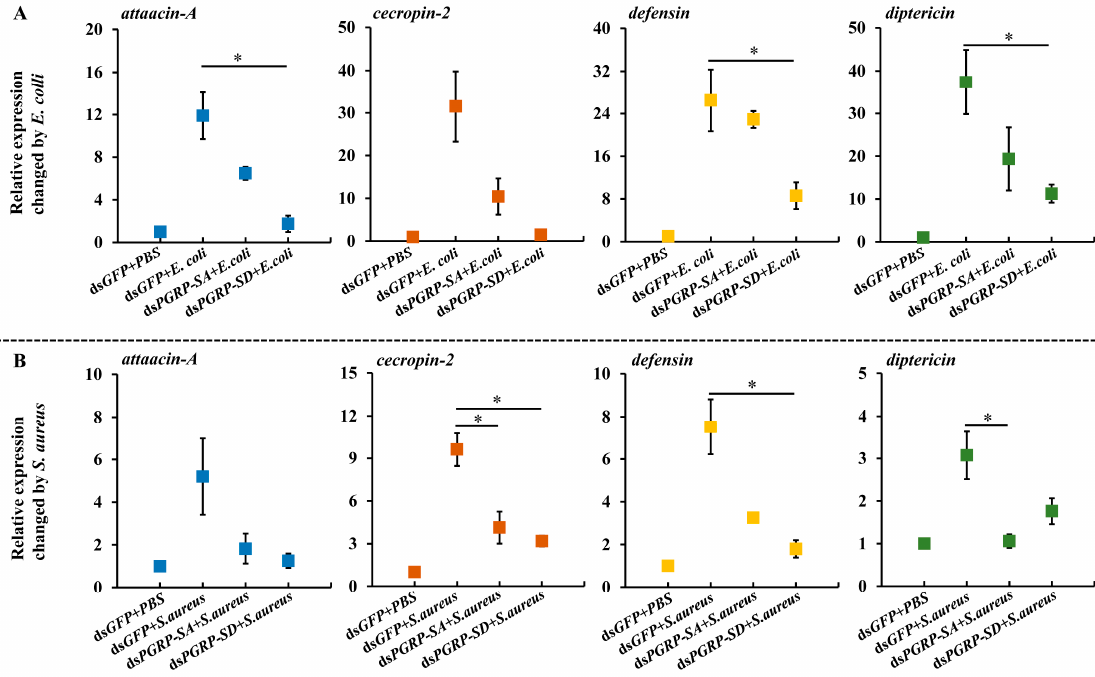
Figure 6. Relative expression level of antibacterial peptides attacin-A , cecropin-2 , defensin , and diptercin after injection with dsRNA and injection with inactivated Escherichia coli ( A ) and Staphylococcus aureus ( B ). The data represent mean ± SE. Significant differences determined by the independent samples t -test (* indicates p < 0.05).